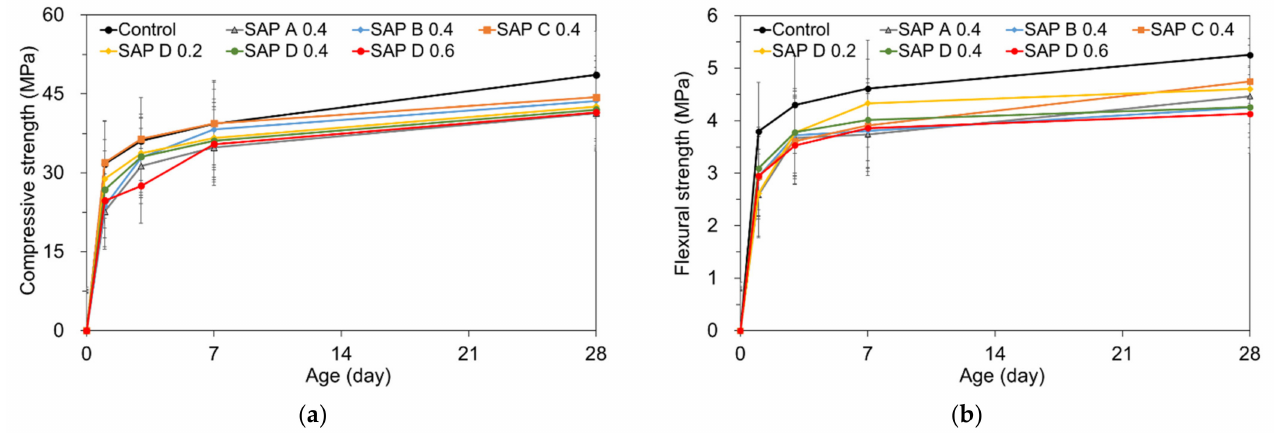
Figure 11. Effect of SAP addition on strengths: ( a ) compressive strength; ( b ) flexural strength.